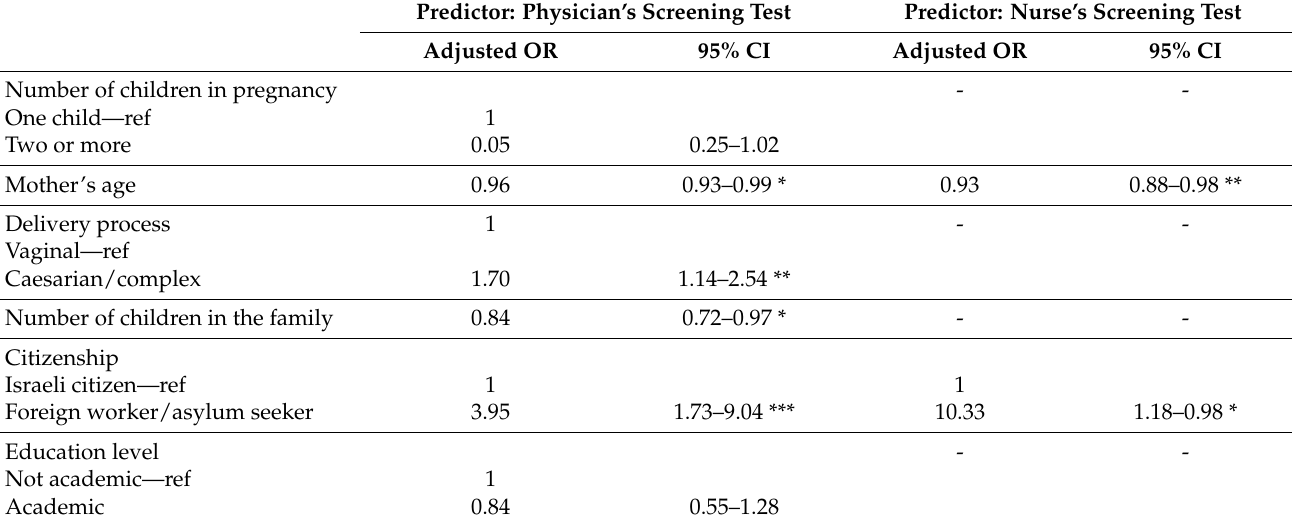
Table 4. Multiple logistic regression for the association between the research variables and not undergoing a physician’s or nurse’s screening test at a MCHC a . Predictor: Physician’s Screening Test Predictor: Nurse’s Screening